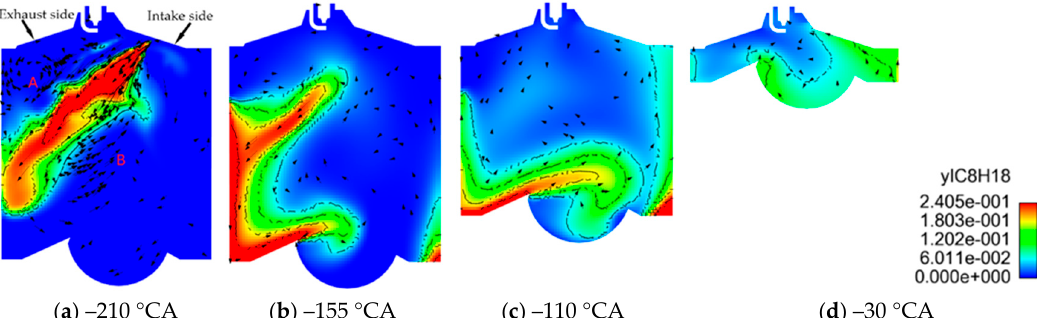
Figure 6. IC 8 H 18 spray cloud and instantaneous velocity field (clip through the spark plug). ( a ) –210 °CA; ( b ) –155 °CA; ( c ) –110 °CA; ( d ) –30 °CA.